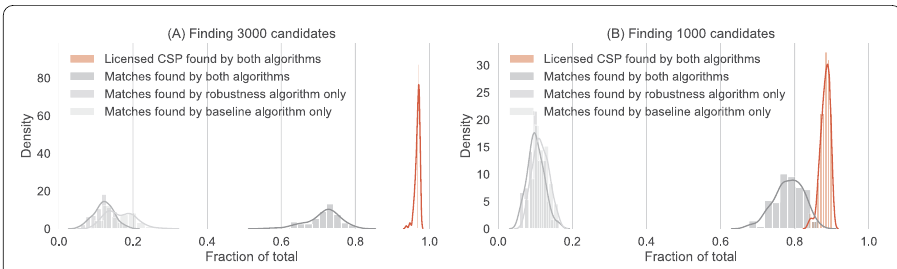
Figure 9 Effects of feature selection. The nearest neighbor algorithm selects directors close to at least ( A ) three ( B ) nine licensed CSPs. Note that both algorithms are able to find the majority of licensed CSPs (the red distribution peaks at around 90-95%), and both algorithms find a similar set of directors (darker